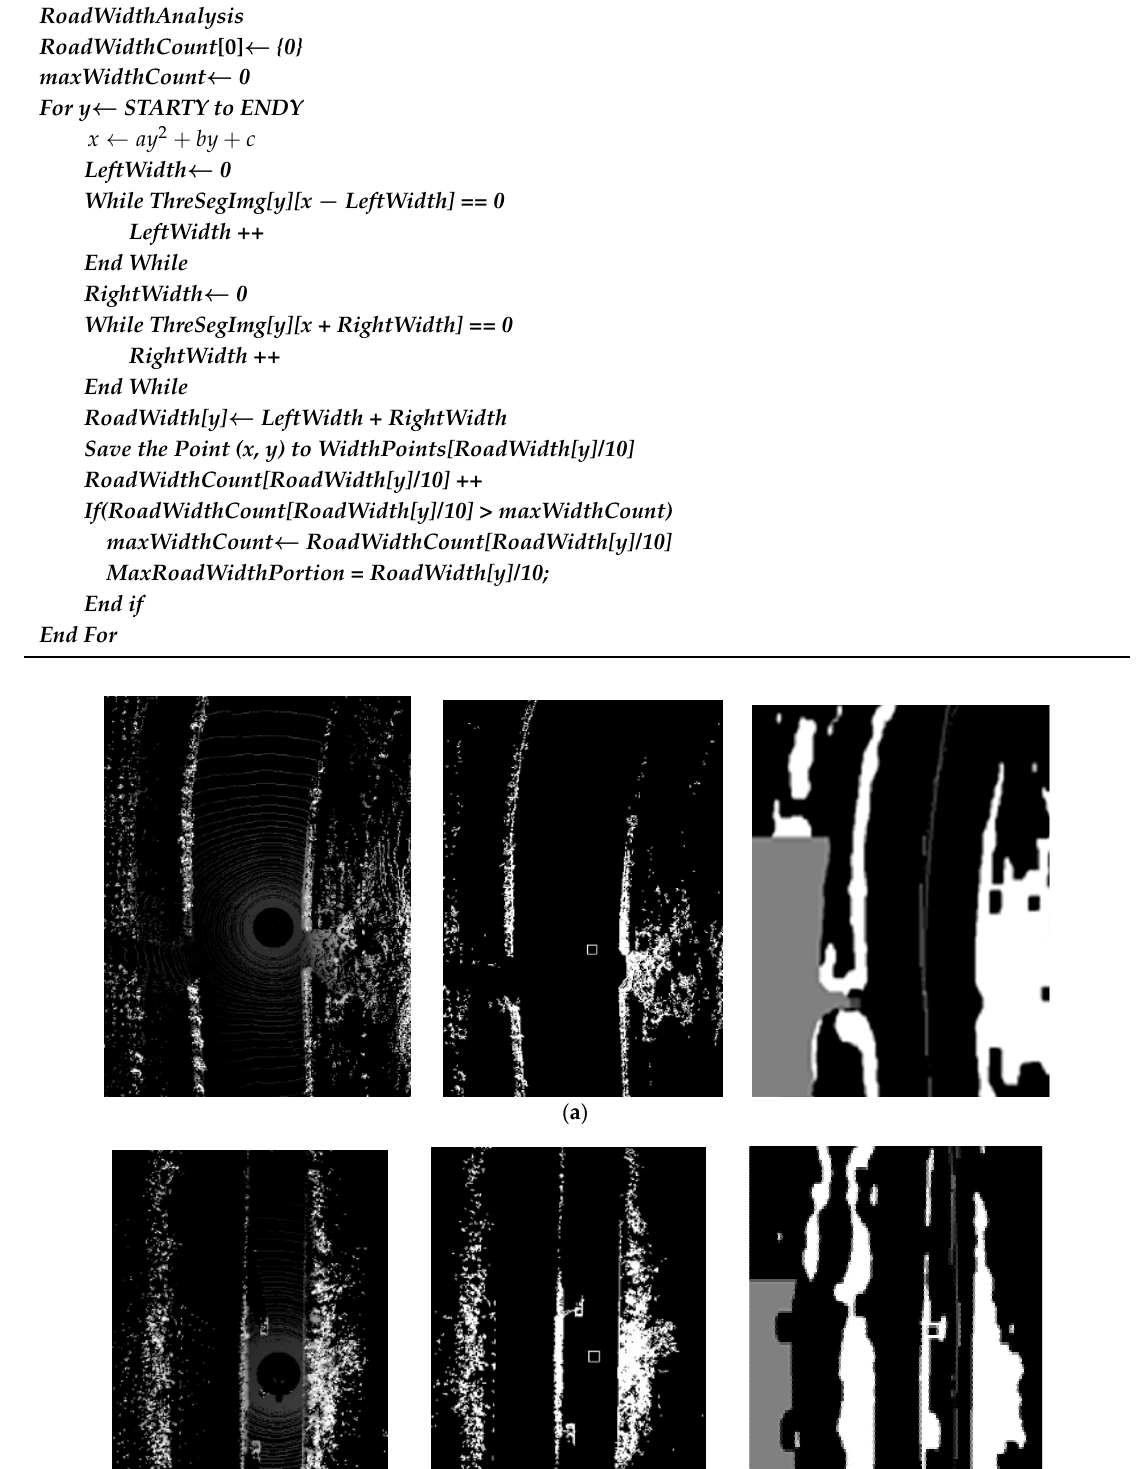
Algorithm 2. Process for the Analysis of Width Distribution RoadWidthAnalysis